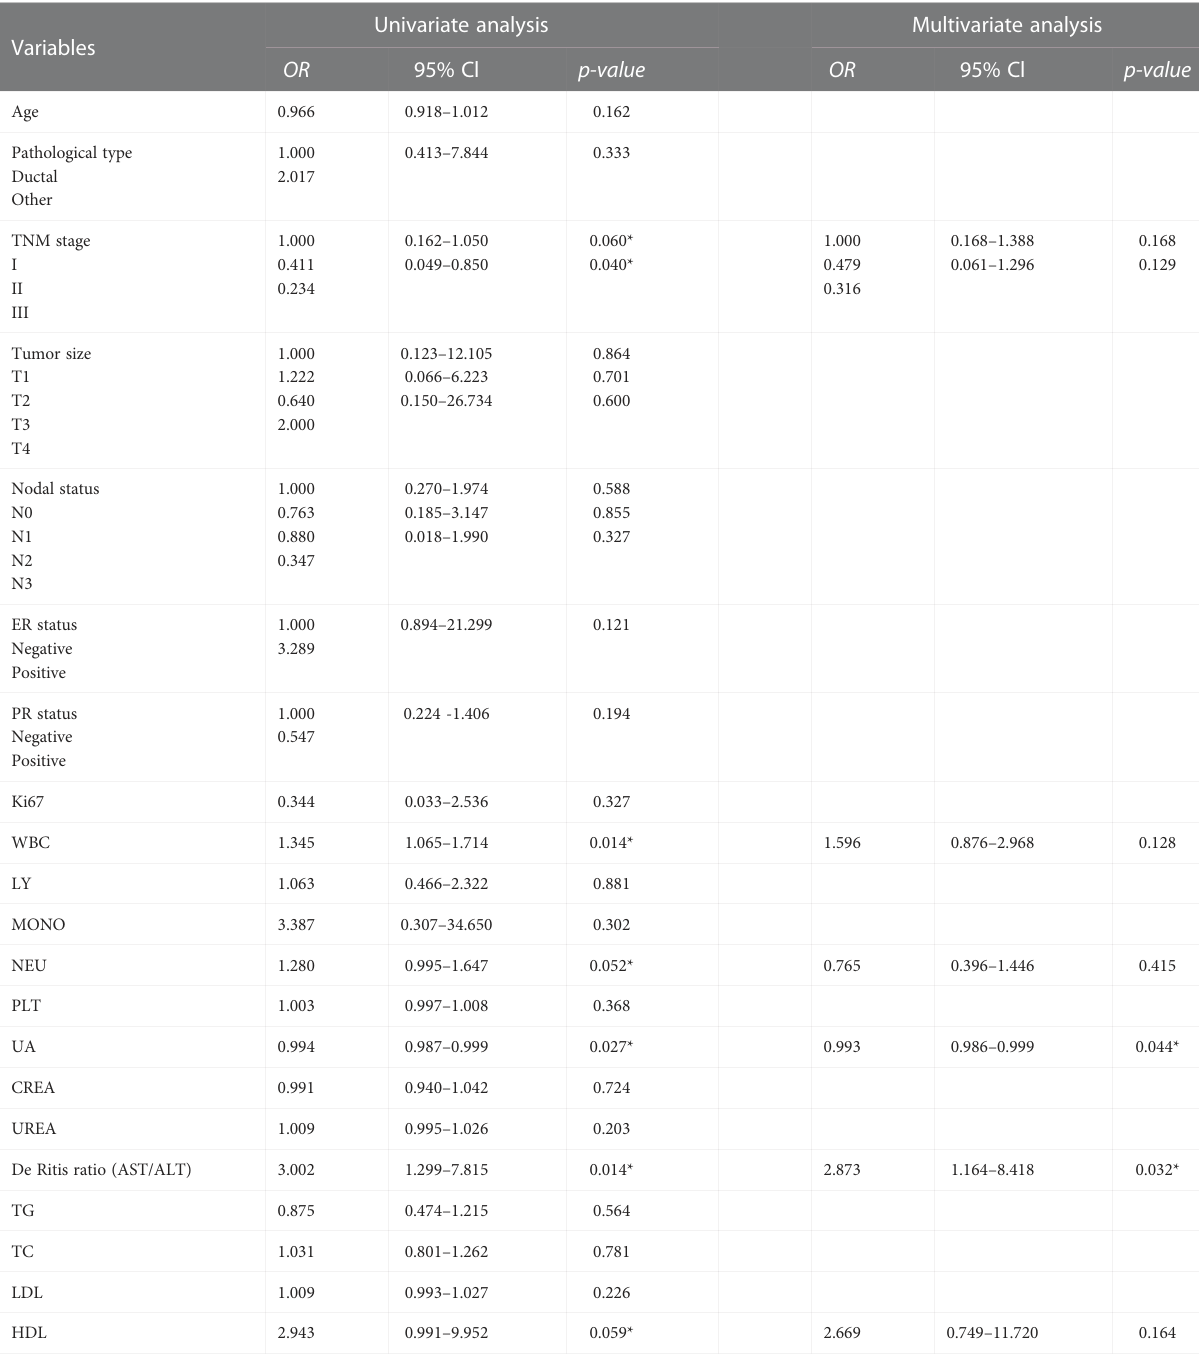
TABLE 3 Logistic regression analysis based on clinicopathological parameters/blood test variables for cHER2